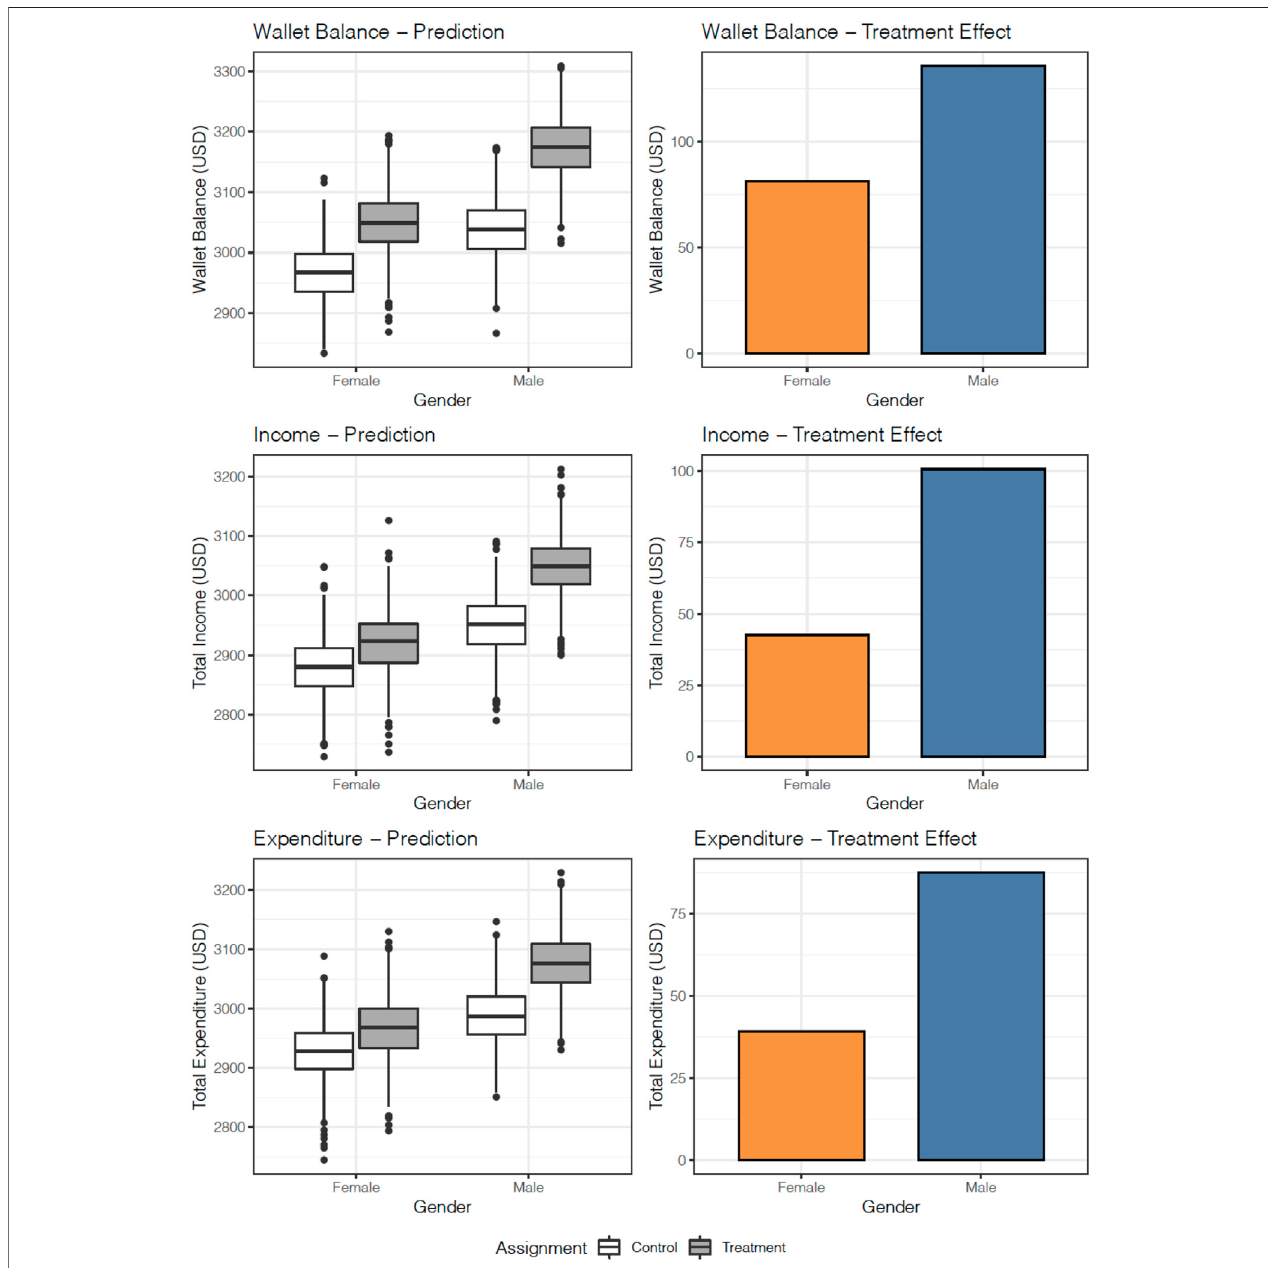
FIGURE 8 | Outcome predictions by cohort (A) and treatment effects by gender (B) .